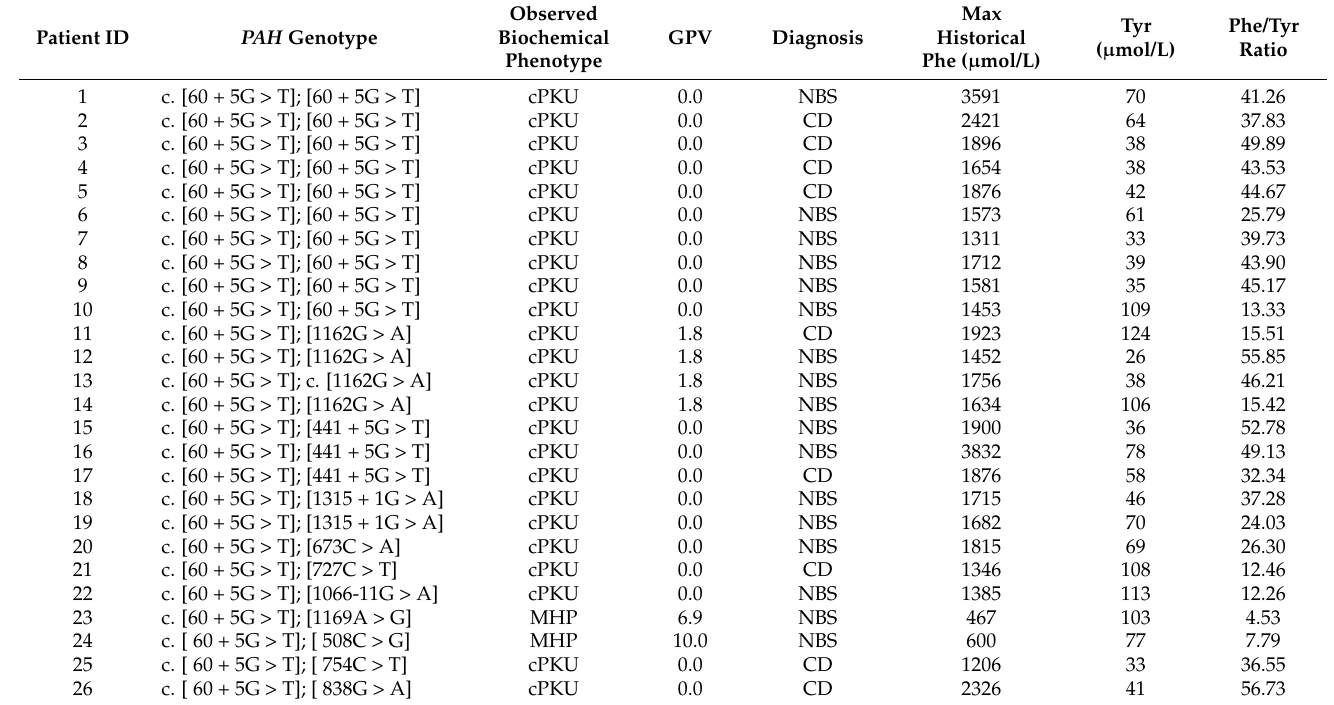
Table 3. Main biochemical and clinical characteristics of the patients harboring the c. 60 + 5G < T variant.